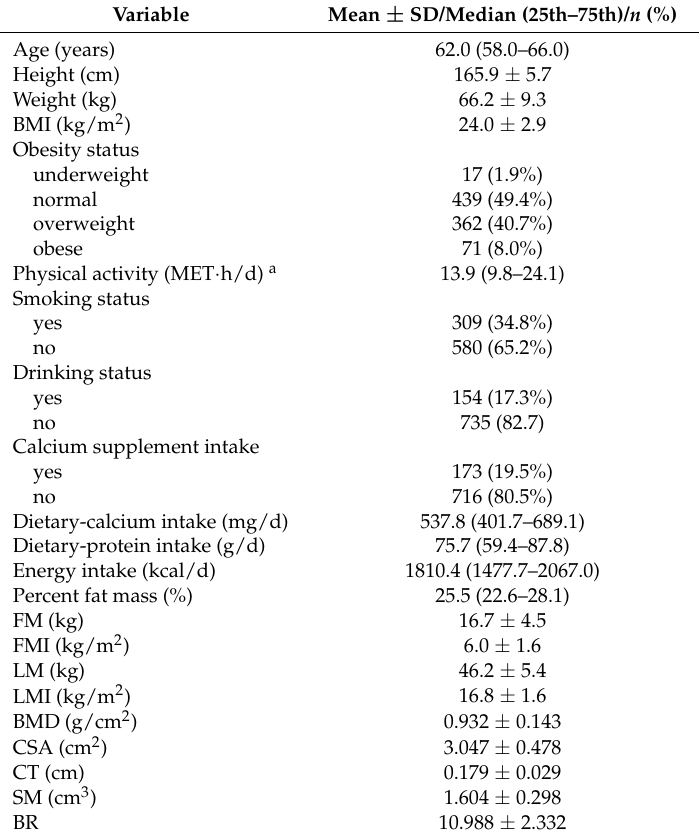
Table 1. Baseline characteristics of the studied sample ( n =